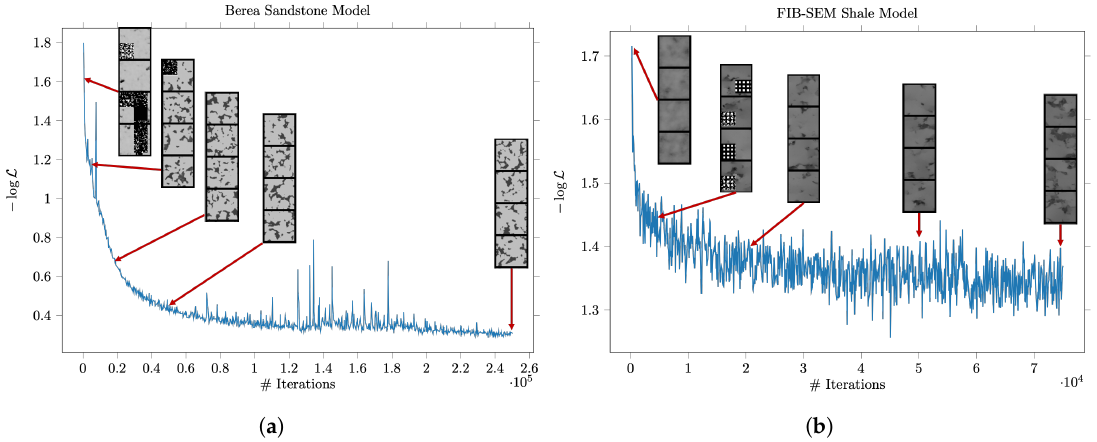
Figure 13. Learning curves for ( a ) Berea sandstone model and ( b ) FIB-SEM image datasets that are binary and grayscale images, respectively. We see that training is much slower for the binary images, and there are still more sampling errors after 50 epochs of training than 25 epochs for the grayscale